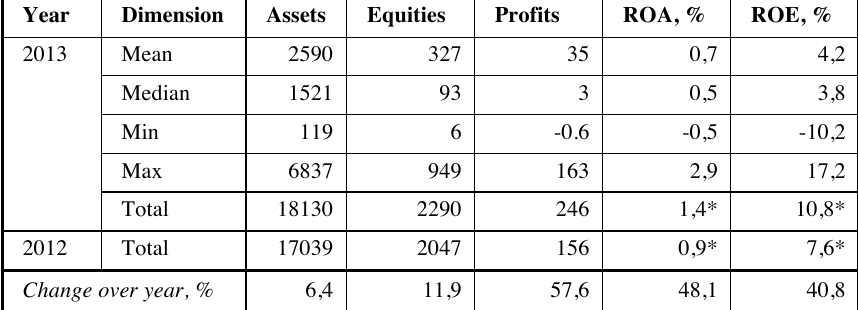
Table 1. Profile of Lithuanian banks, million Euros (calculations made using data from banks’ annual accounts) Year Dimension Assets